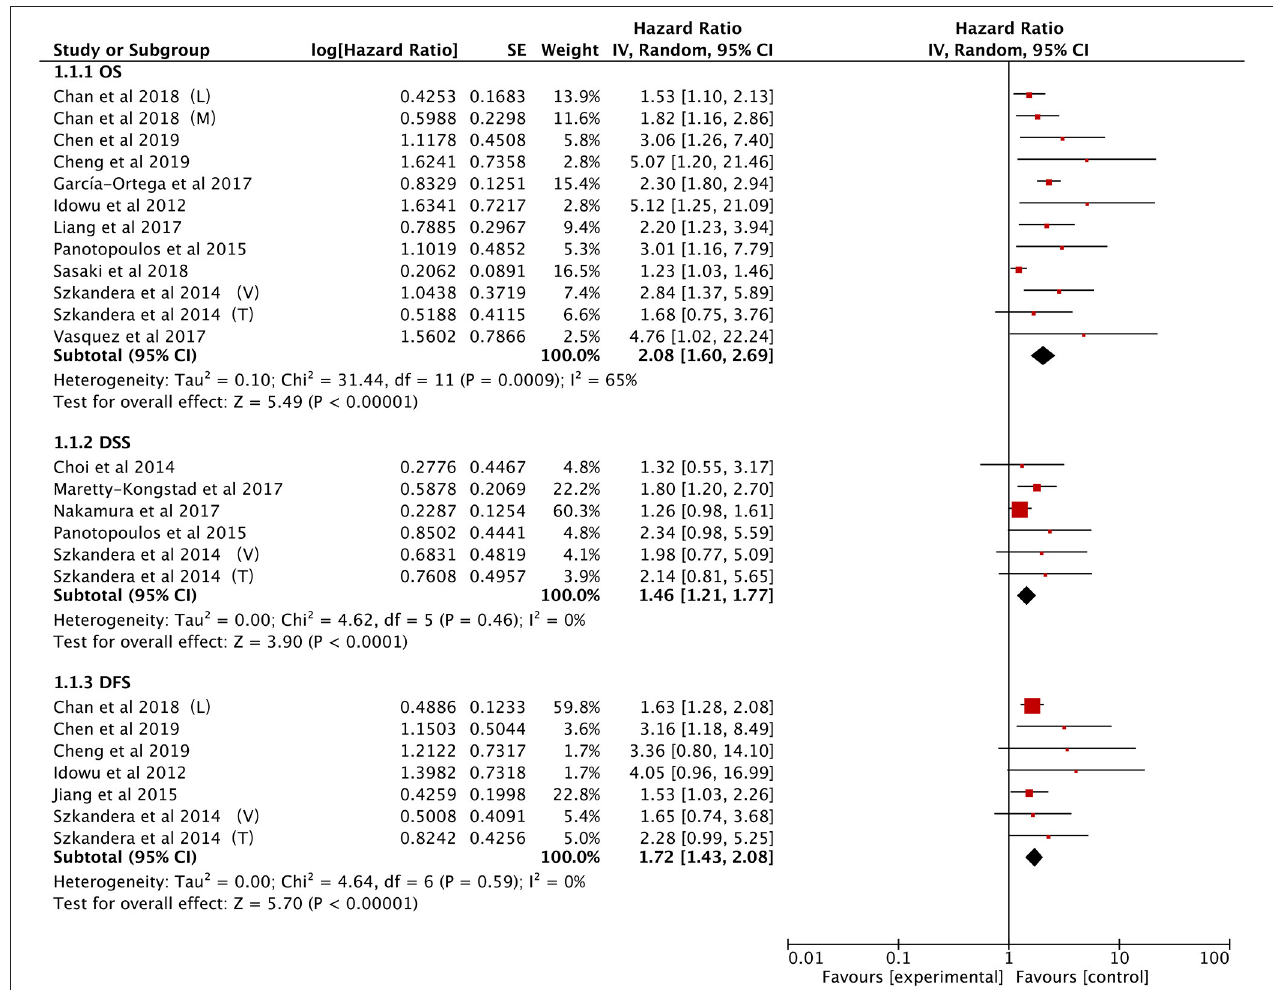
FIGURE 2 | Forest plots of the Prognostic effect of NLR for